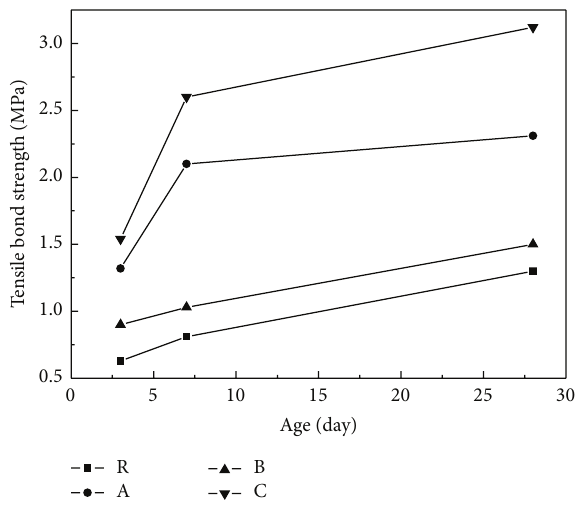
Figure 2: Tensile bond strength of repair mortars before and after erosion by 5% HCl solution.